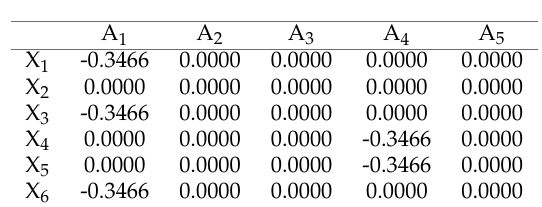
Table 4. The p ij ln p ij values